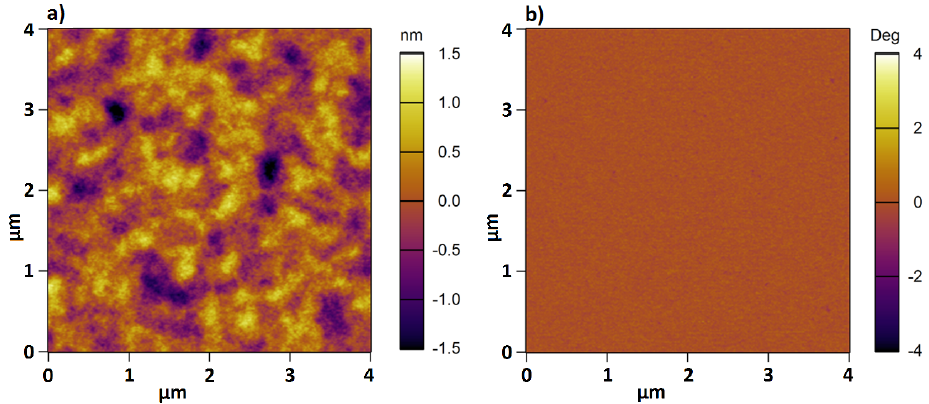
Figure 3. AFM height ( a ) and phase ( b ) image for sample 1 in Mili-Q water at room